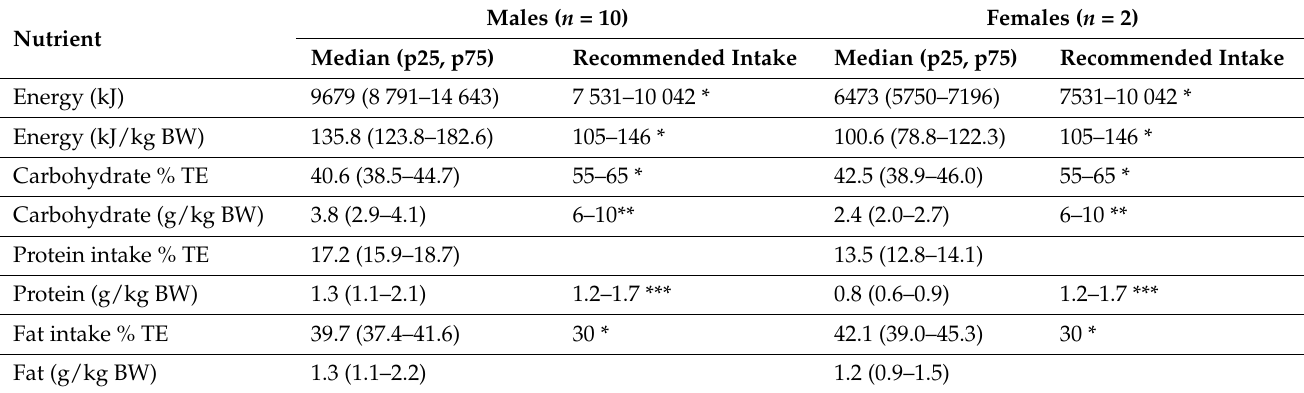
Table 3. Macronutrient intake ( n =